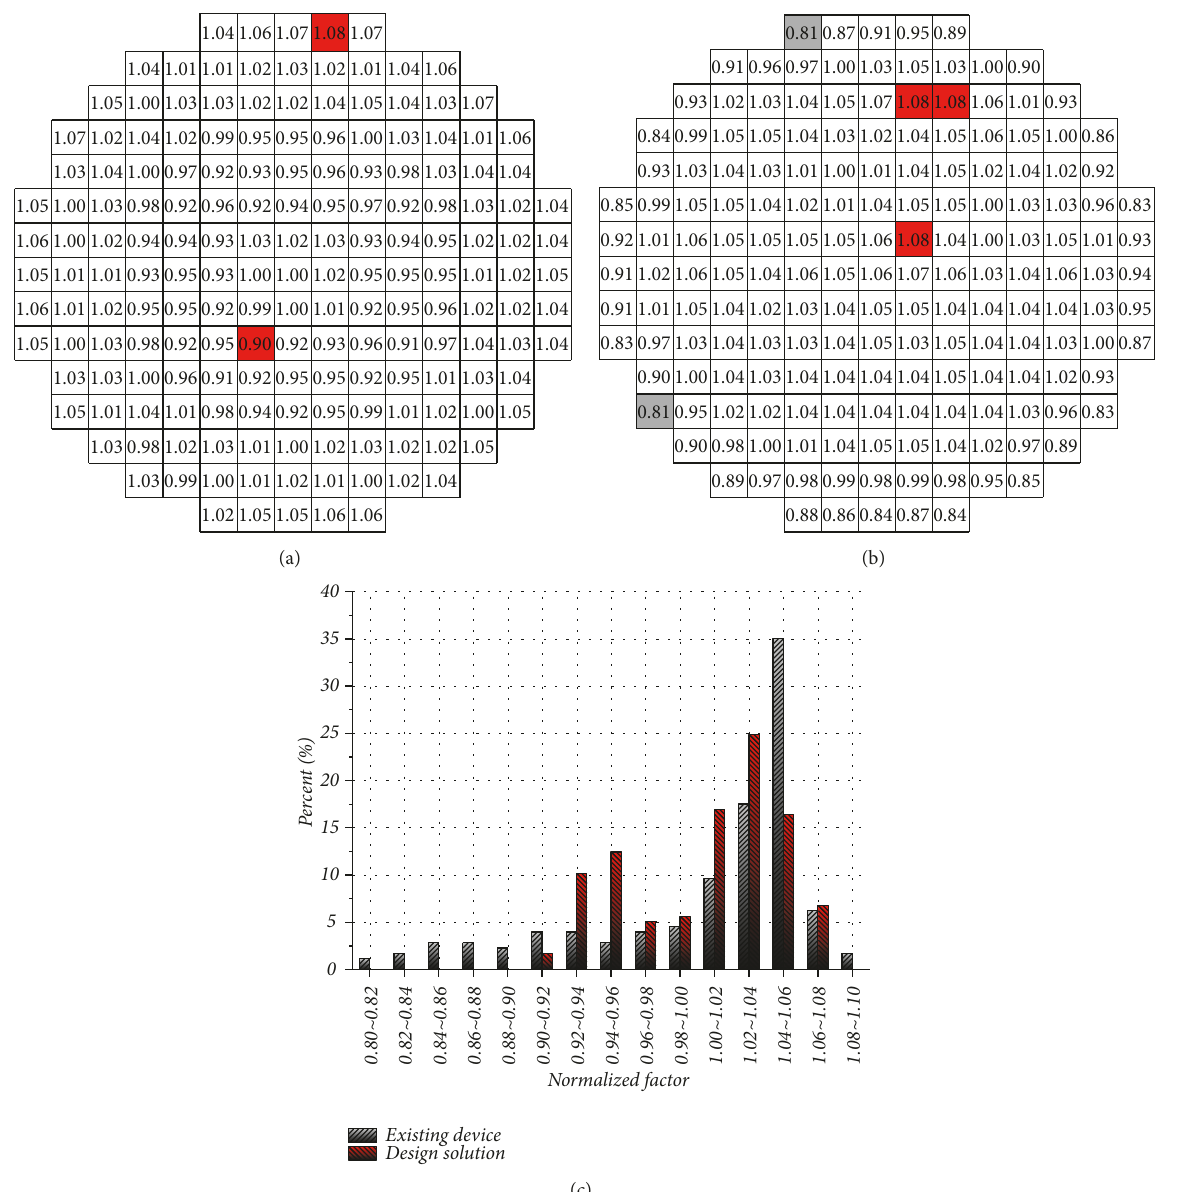
Figure 11: Normalized factor at the core inlet. (a) Innovative solution. (b) Existing device. (c) Normalized factor proportions comparison.